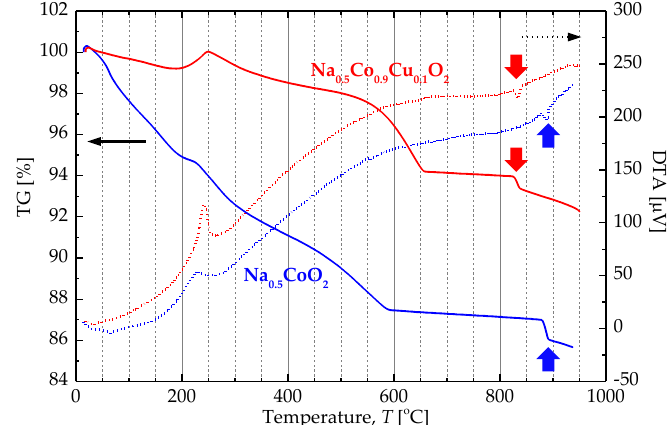
Figure 2. ( a ) Cross-sectional schematic and ( b ) photograph of a partially improved Na 0.5 CoO 2 thick film with NaCl mixing and a CuO interlayer introduction.